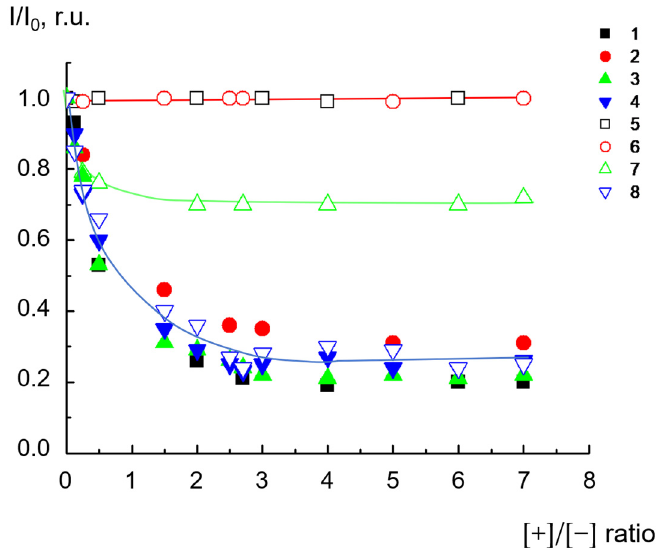
Figure 7. Relative fluorescence intensity of label (DOPE-CF) in dendrimer–liposome complexes as a function of ratios of ionic groups [+]/[ − ] for D 350+ (1, 5), D 229+ (2, 6), D 215+ (3, 7), and D 16+ (4, 8) before (1–4) and after (5–8) NaCl addition. [NaCl] = 0.4 mol/L. CL/Chol/DOPC liposomes, [CL] = 1.5 × 10 − 4 mol/L, total lipid concentration of 1 mg/mL. 10 − 3 M phosphate buffer, pH 7.2.